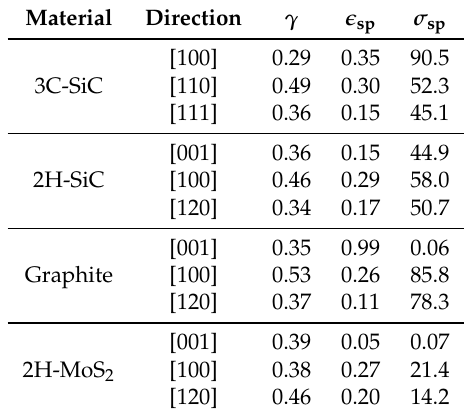
Table 1. One dimensional (1D) spinodal equation of state (1D-SEOS) parameters from the fittings to our computed stress–strain data. Units of σ sp are